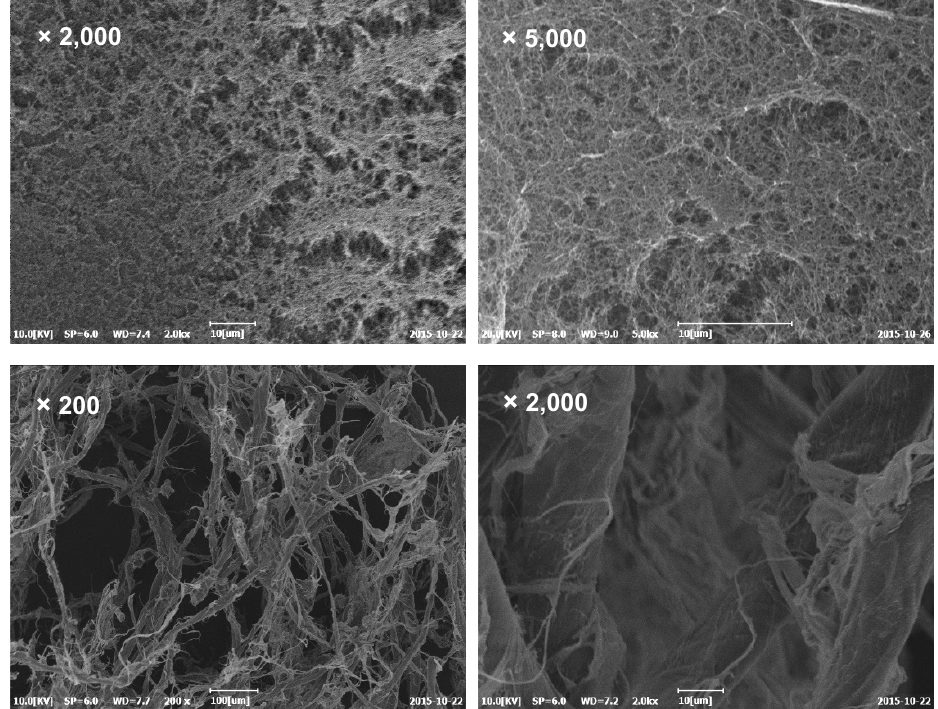
Figure 2. Scanning electron microscope images of cellulose aerogels ( upper : dissolved in cellulose dissolution of calcium thiocyanate with six ( left ) and seven ( right ) hydrates, lower : undissolved in cellulose dissolution of calcium thiocyanate with nine ( left ) and 10 ( right ) hydrates).